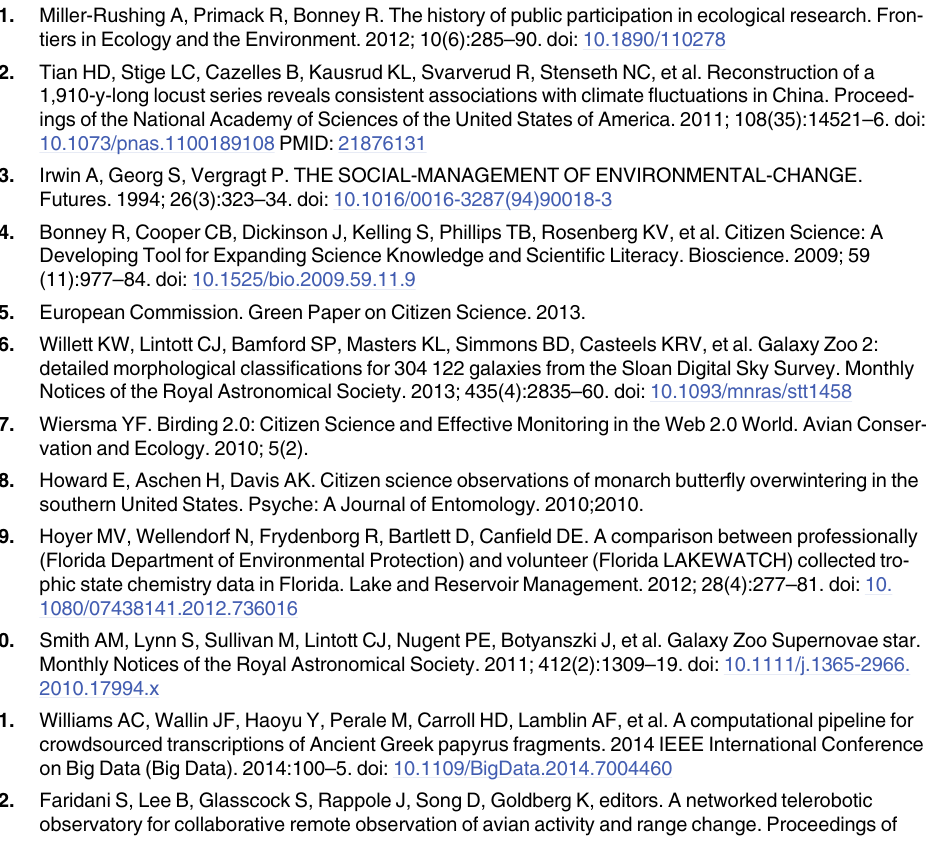
S1 Table. Criteria used in Coding Articles. A table defining the criteria used for coding the articles into their